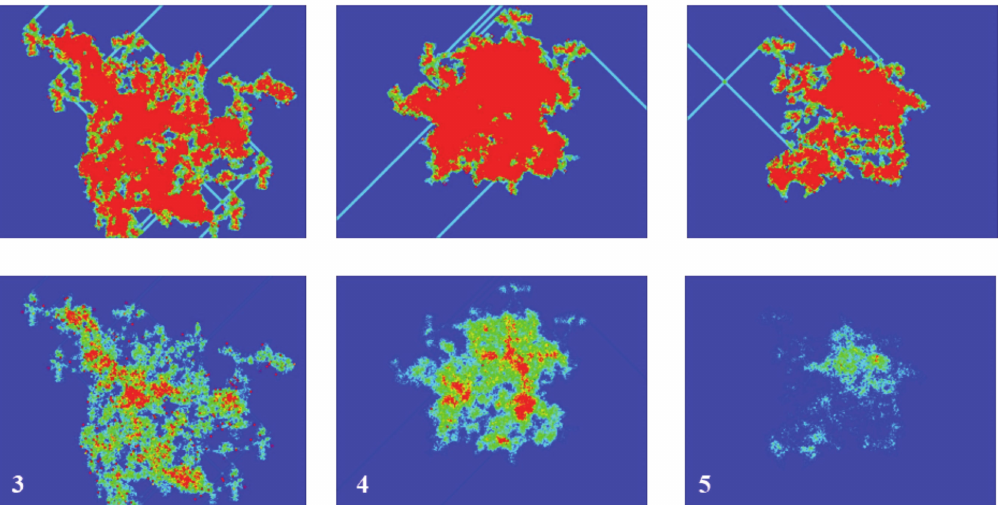
Figure 5. (Color online) Three different simulations with random configuration of equal initial density (20%). Top panel: Active area A A . The straight lines correspond to the traces left by gliders. Bottom panel: Spiked area A S , i.e., neurons that have spiked at least once. From left to right, Spiking Rules R3, R4, and R5, respectively (see Section 4). Color scale in both panels is between 0 (dark blue) and 20 (red). All results correspond to time